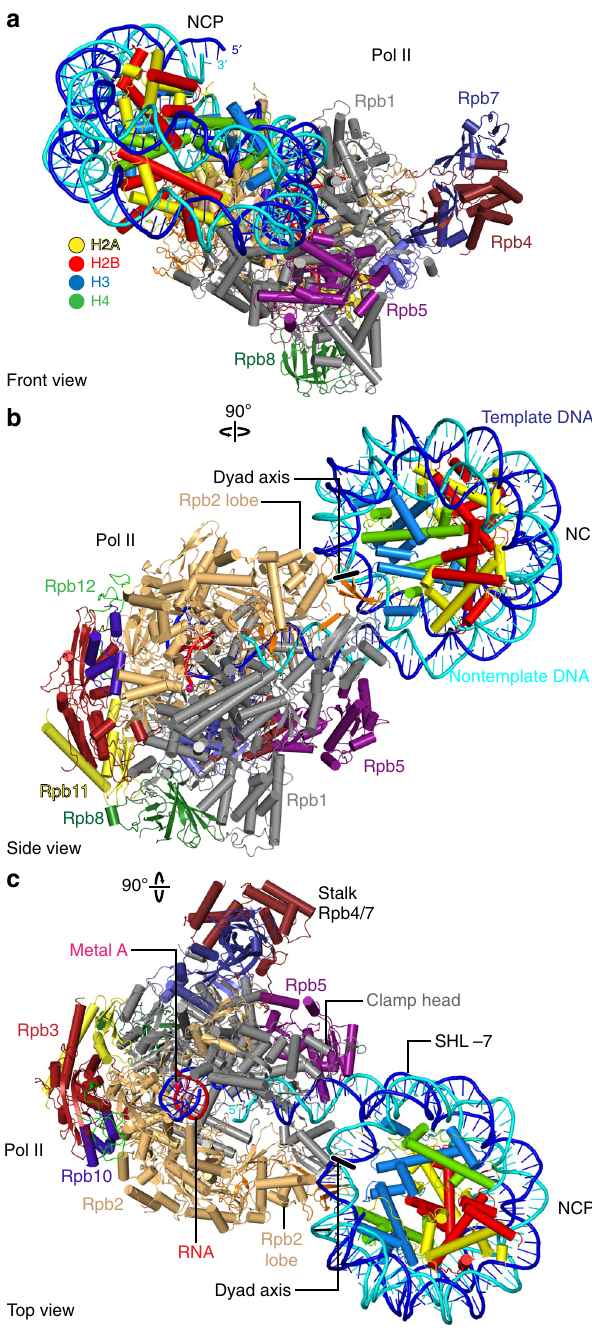
Fig. 1 Structure of Pol II – NCP complex. a – c Cartoon model viewed from the front ( a ), side ( b ), and top ( c ). Pol II subunits Rpb1 – Rpb12, template DNA, non-template DNA, RNA, H2A, H2B, H3 and H4 are coloured in silver, sand, ruby, deep purple, slate, cyan, deepblue, forest green, orange, purple, yellow, green, blue, cyan, red, yellow, crimson, light blue and green, respectively. Colour code used throughout. Histone octamer dyad axis is indicated as a black line with white outline